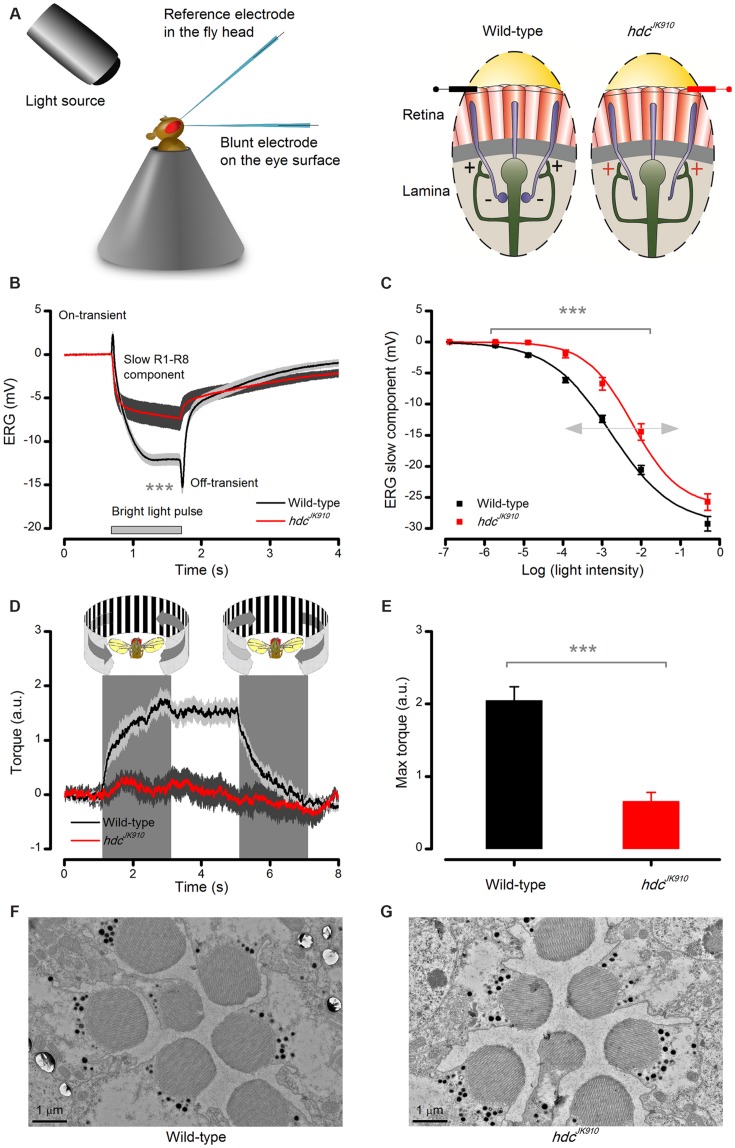
Lack of photoreceptors’ neurotransmitter histamine makes hdcJK910 mutants blind.
(A) Schematic shows how electroretinograms (ERG) were recorded in vivo from intact Drosophila, restricted inside a conical holder (left). Corneal electrodes (left) were used to pick up electrical signals of light-induced global eye activity, which in the wild-type is dominated by slow photoreceptor and fast lamina interneuron components (on- and off-spikes). In each lamina cartridge, inhibitory (histaminergic) feedforward signals from R1–R6 photoreceptor axons (minus-signs) transmit information from the same small area in the visual space. In return, R1–R6 axons receive excitatory (cholinergic and glutamatergic) feedback signals (plus-signs) from L2/AC and L4 interneurons. hdcJK910 mutants lack the inhibitory feedforward. (B) ERGs measured from hdcJK910 and wild-type flies to 1 s long very bright red (640 nm) pulse. Mutant ERGs showed remarkably smaller Photoreceptor Component (ERGPChdc = -7.5 ± 1.3 mV, ERGPCwild-type = -14.6 ± 0.8 mV, p = 4.594 × 10-4, nhdc = 7, nwild-type = 8 flies) and no on- and off-transients. The large transients in wild-type flies indicate normal neurotransmission from photoreceptors to interneurons. (C)
hdcJK910 ERG’s photoreceptor component was consistently smaller than that in the wild-type over a broad intensity range (p < 3.50 × 10-4, one-tailed t-test, nhdc = 10, nwild-type = 10 flies), indicating 10-fold reduced sensitivity. Data fitted by the standard V/logI equation (Hill-equation): V =Vmax⁡(InIn+I50n). (D) Optomotor responses of tethered flying wild-type and hdcJK910 flies to left (counter-clockwise) and right (clockwise) stripe-field rotations, measured in a classic Drosophila flight simulator system. Wild-type flies generate clear and consistent yaw torque responses, intending to follow the field rotations, while the responses of hdcJK910 flies seem haphazard. (E) The maximum optomotor responses of hdcJK910 flies are significantly weaker than those of wild-type flies (ORhdc = 0.7 ± 0.1 a.u., ORwild-type = 2.0 ± 0.2 a.u., p = 1.56 × 10-4, one-tailed t-test, nhdc = 5, nwild-type = 7 flies). (F) Characteristic electron micrograph of R1–R7 photoreceptors in wild-type retinae. (G) Characteristic electron micrograph of R1–R7 photoreceptors in hdcJK910 retinae. Whilst overall hdcJK910 photoreceptors’ ultrastructure seems normal, the mean R1–R6 rhabdomere cross-sectional area is 28.6% smaller than that of the wildtype (Rhabhdc = 2.05 ± 0.06 μm2, Rhabwild-type = 2.87 ± 0.13 μm2, p = 7.71 × 10-7, one-tailed t-test, nhdc = 18 cells, nwild-type = 18 cells, 3 flies). (B–E) Mean ± SEM. All recordings performed at t = 19°C.